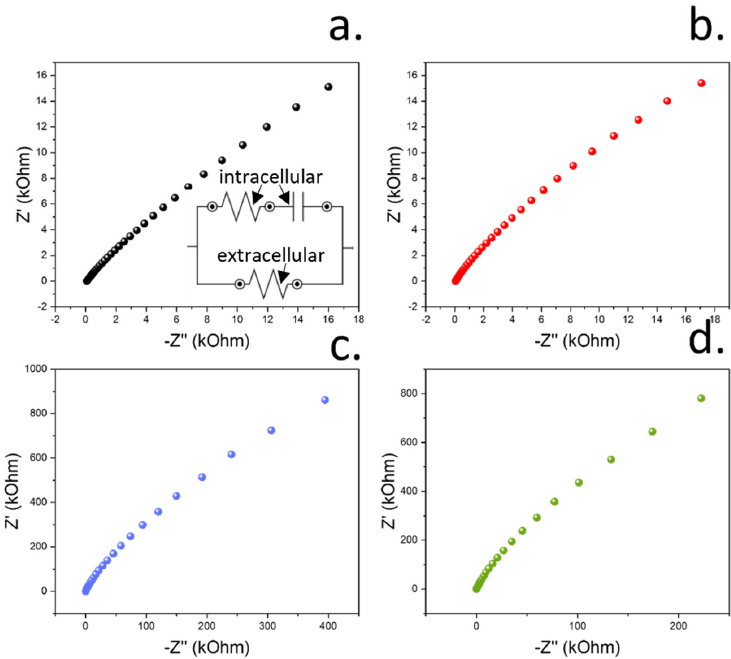
Figure A2. Example of the program for the potentiostat developed for XOD, visual programming for the easy application of the device.